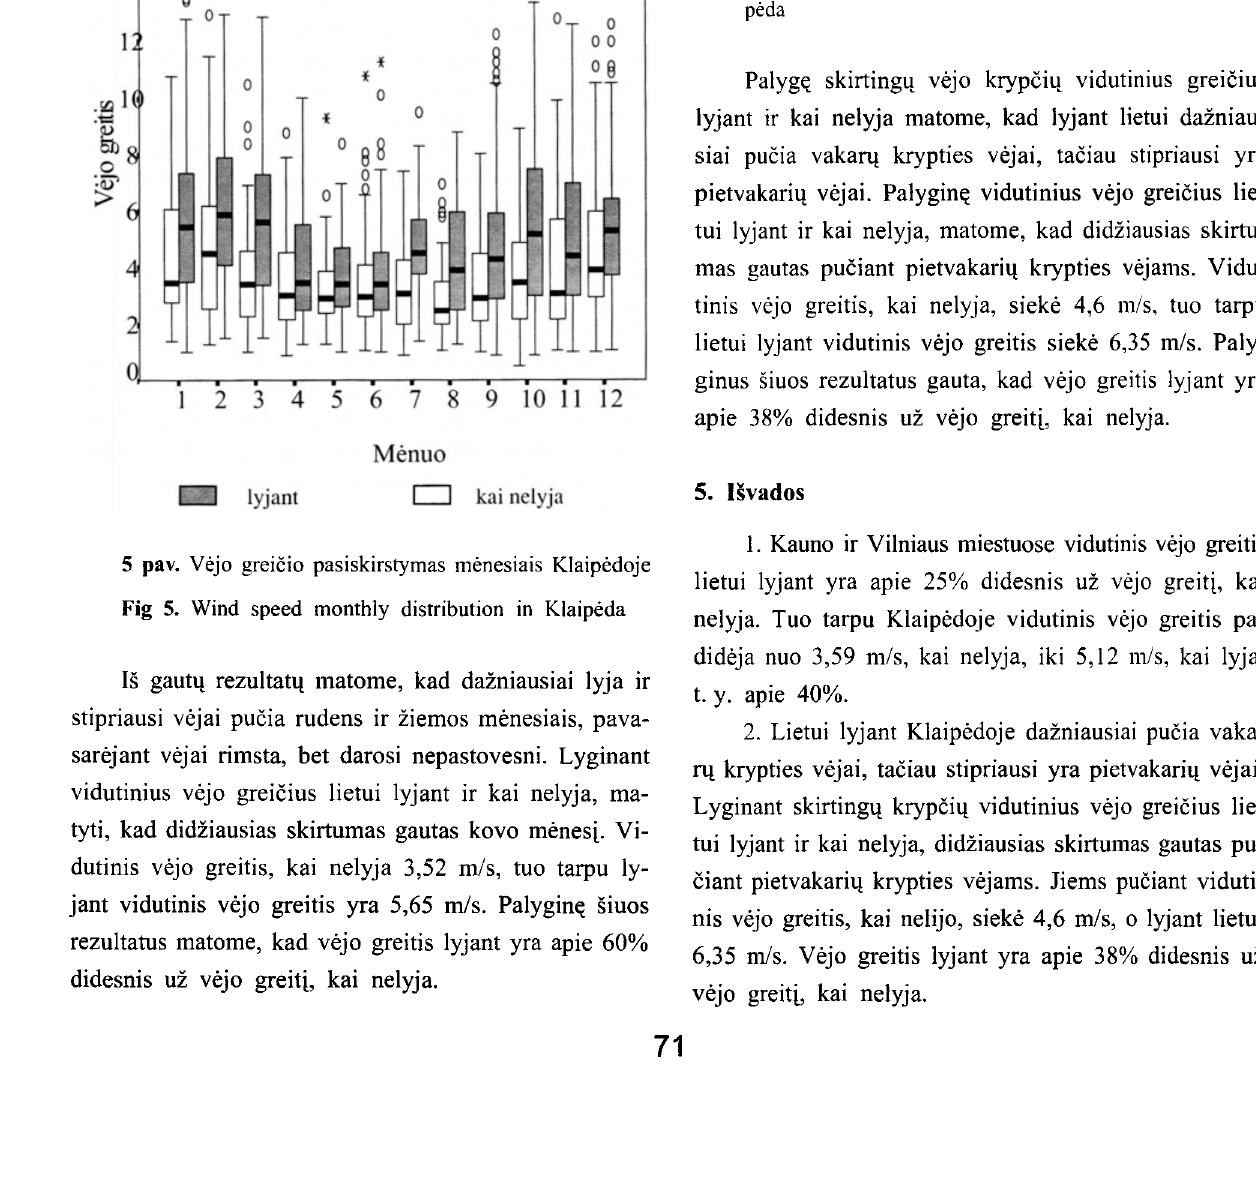
niuje silpnesni kaip 6,4 m/s.